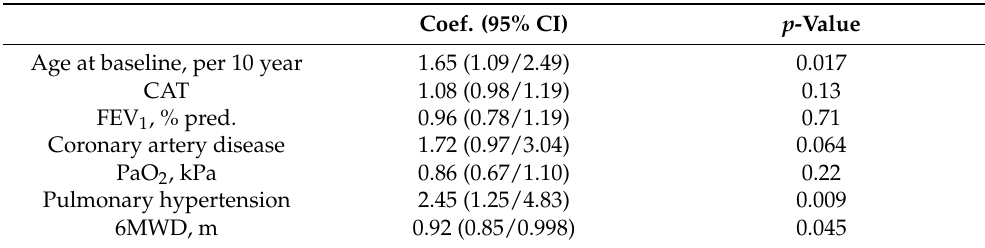
Table 2. Multivariable joint model.